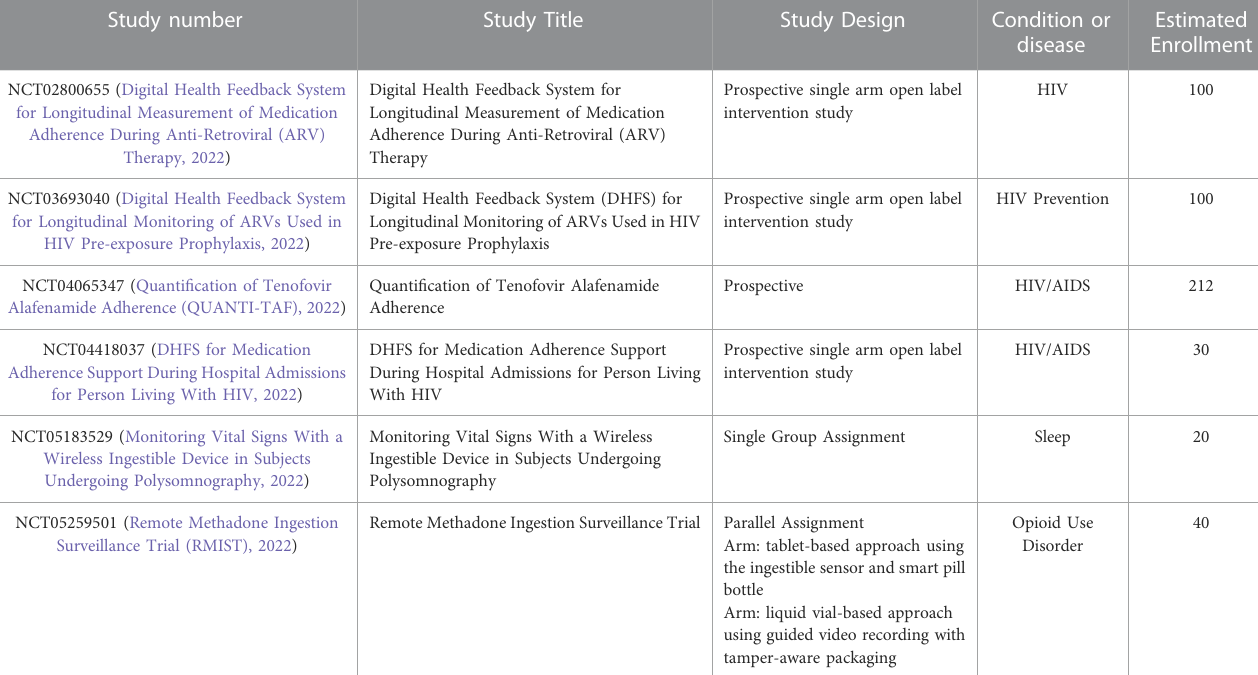
TABLE 7 Examples of on-going clinical trials of digital pills. Study